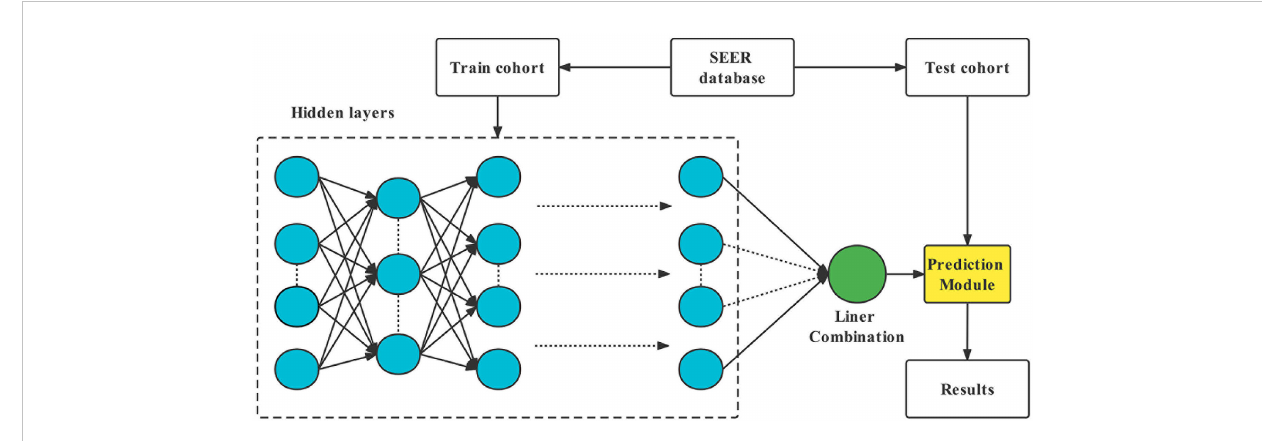
FIGURE 2 Diagram of the deep learning